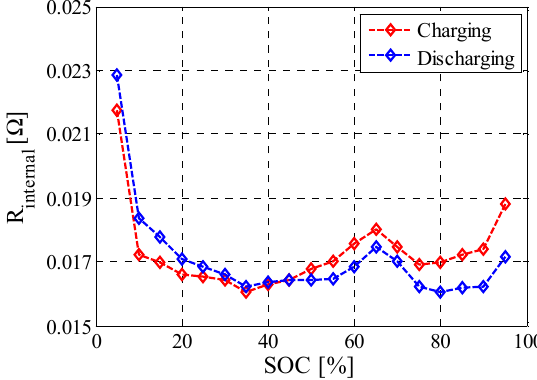
Figure 9. Measured impedance of the LFP/C battery during 18 s charging and discharging current pulse (1C-rate, T = 25 °C).